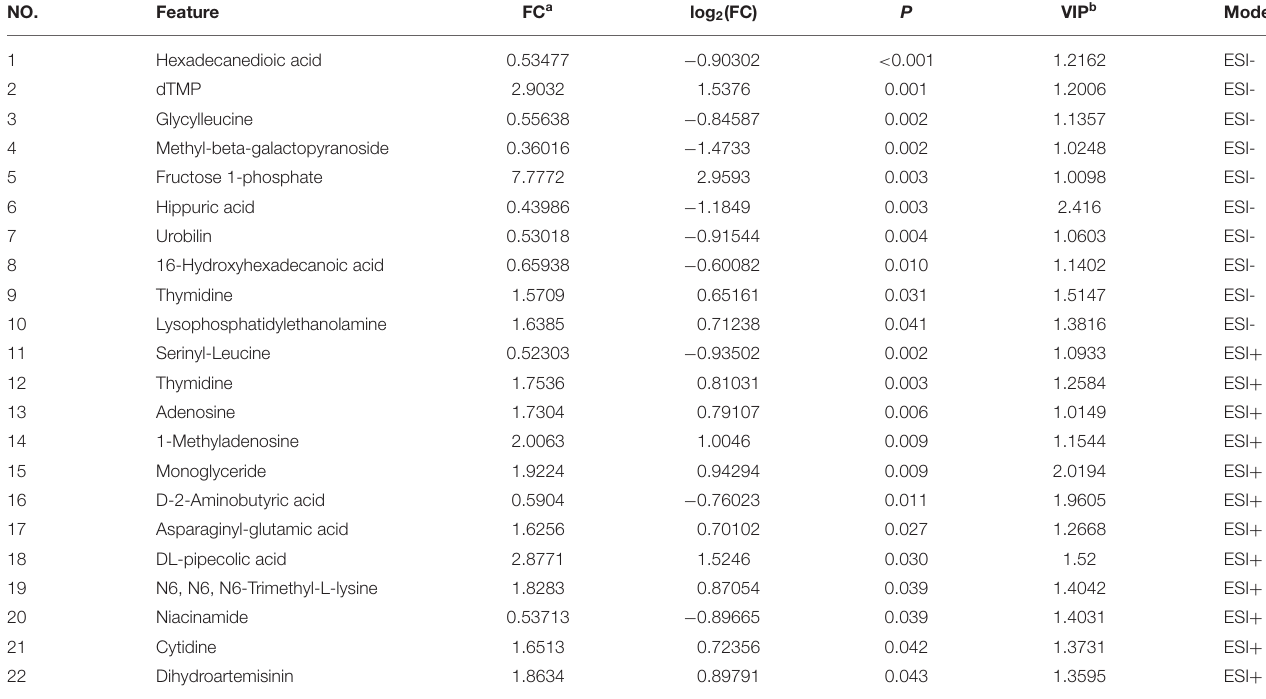
TABLE 2 | Identification of significant differential features in colonic digesta of growing pigs.